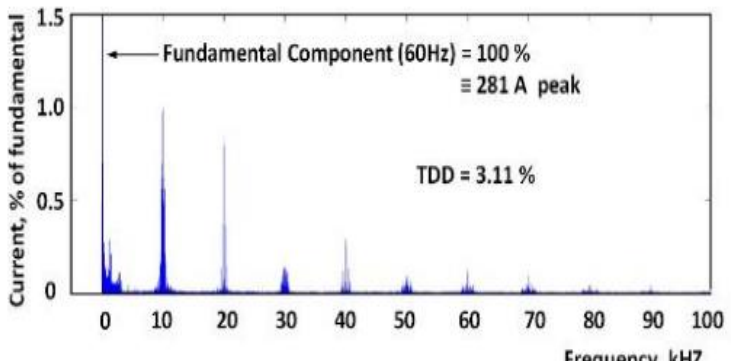
Figure 15. Harmonic components of the line currents up to the 50th were obtained by three-phase, three-wire connection for the operating conditions in Figure 14a.